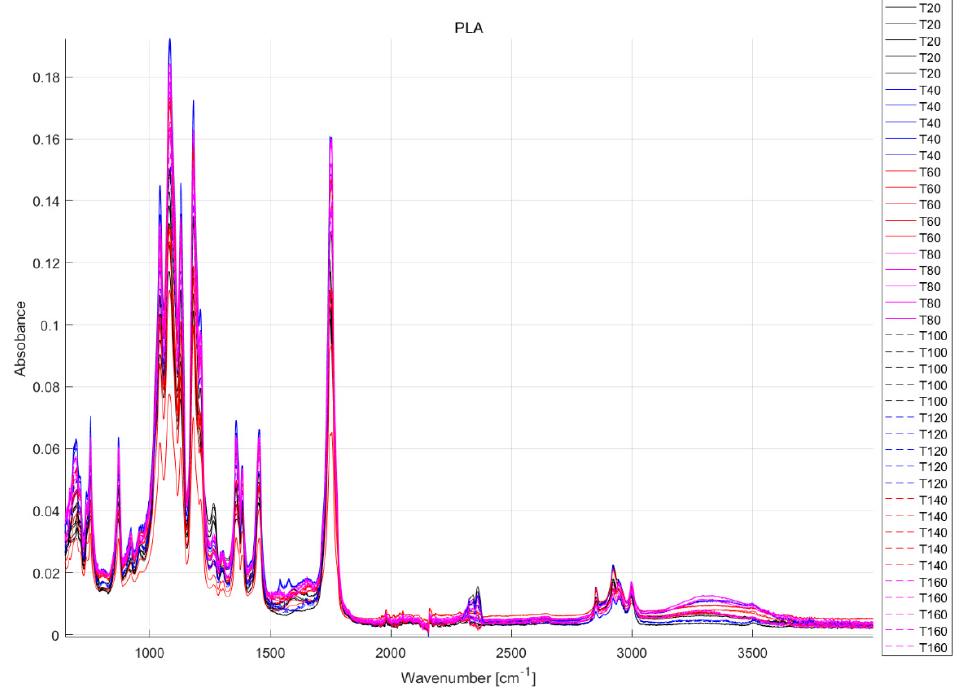
Figure 3. Forty FTIR spectra for all degradation cases.